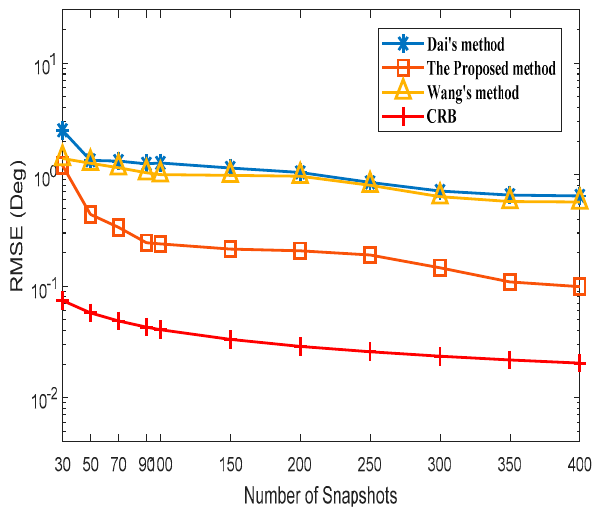
Figure 3. The RMSE versus snapshots for different methods ( M = 8 and SNR = 10